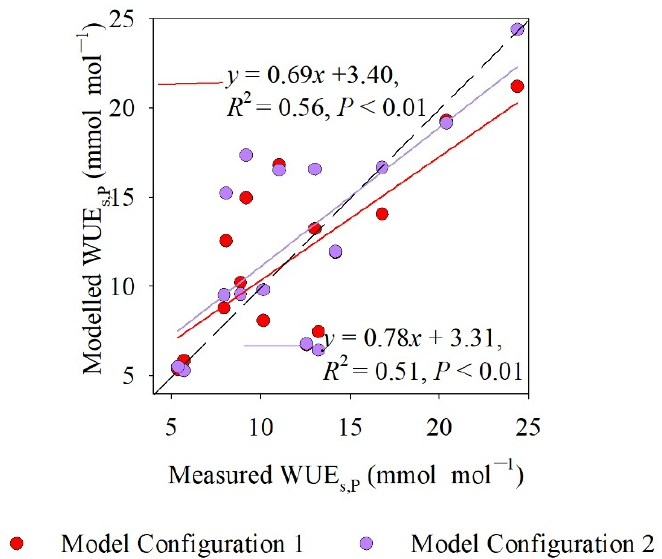
Figure 8. Measured ( a ) and modelled ( b ) whole-plant short-term water use efficiency (WUE s,P , mmol · mol − 1 ) under five soil water contents (SWC) × three CO 2 concentrations ( C a ) conditions. C 400 , C 600 , and C 800 are C a of 400, 600, and 800 µ mol · mol − 1 . Data represent mean values ± SD.